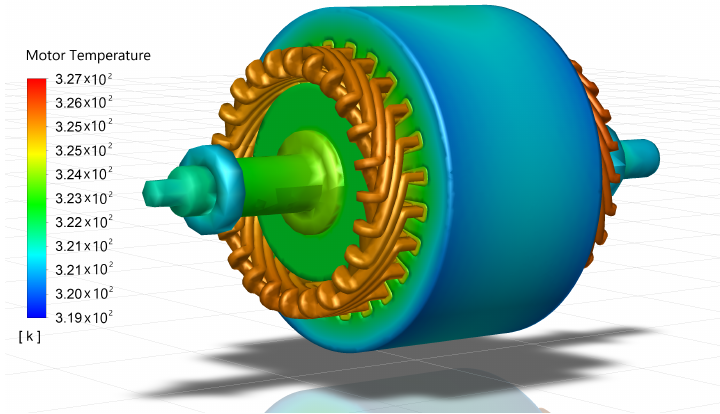
Figure 9. DSOF motor temperature distribution.